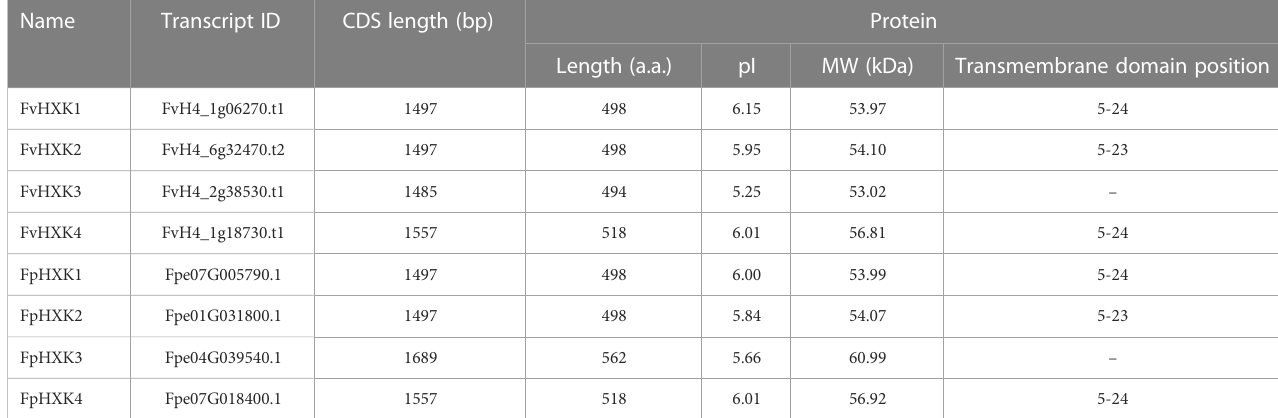
TABLE 1 Basic information of hexokinase genes in F. vesca and F. pentaphylla